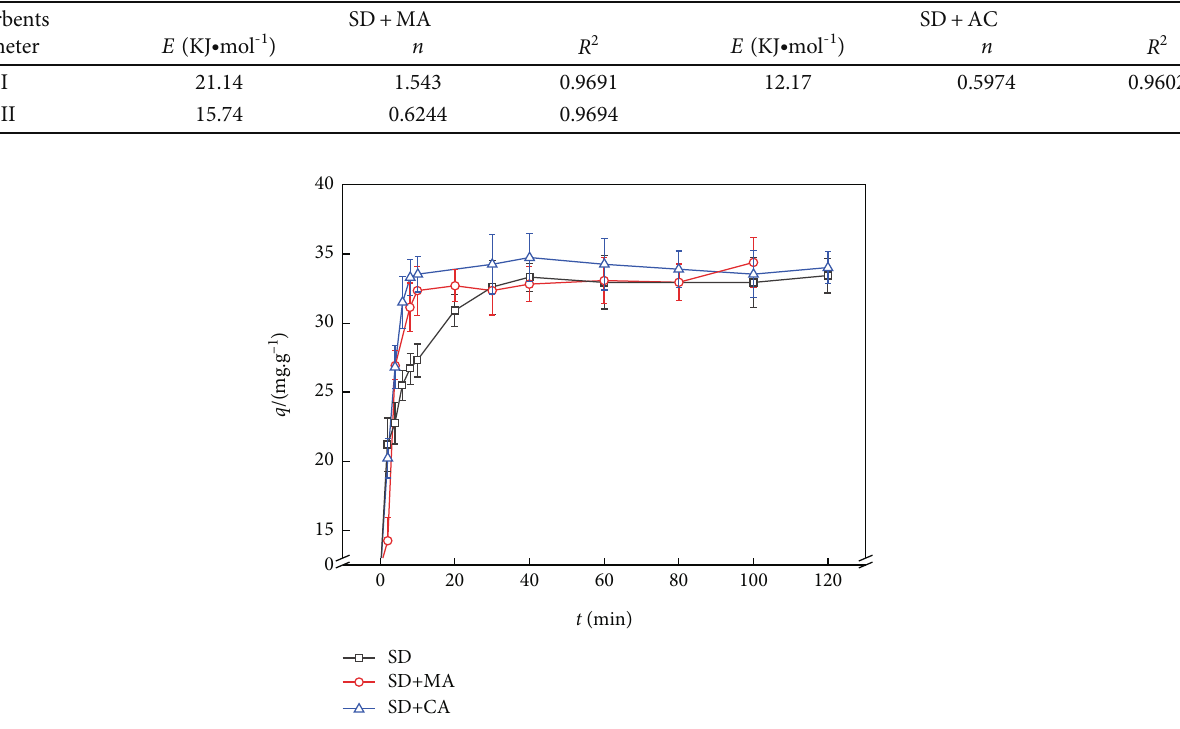
Figure 10: E ff ect of reaction time on removal of boron chloride on SD, SD +MA, and SD+CA.